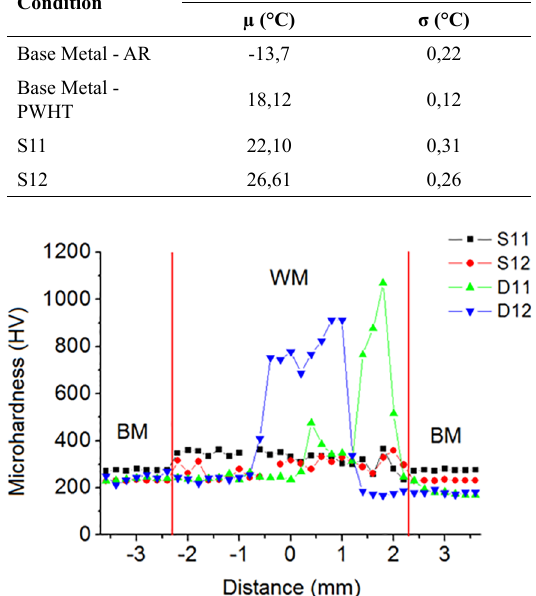
Figure 6. Microhardness profile of the welded joints, the AISI 304 base metal is located at the right side for the dissimilar joints.